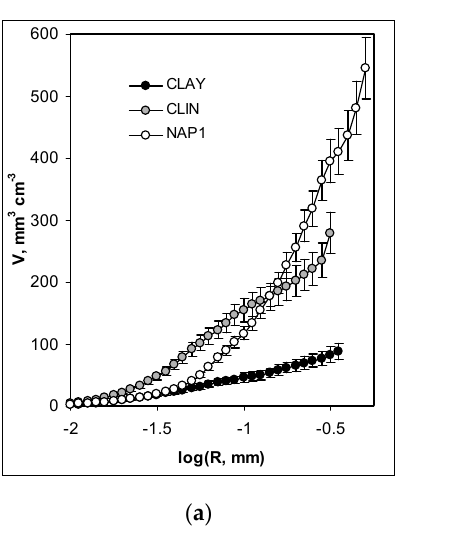
Figure 5. Pore volume vs. pore radius dependencies ( a ) and normalized pore size distribution functions; ( b ) derived from microtomography scans. The points show average results, while the error bars show differences between the average and the experimental replicates.